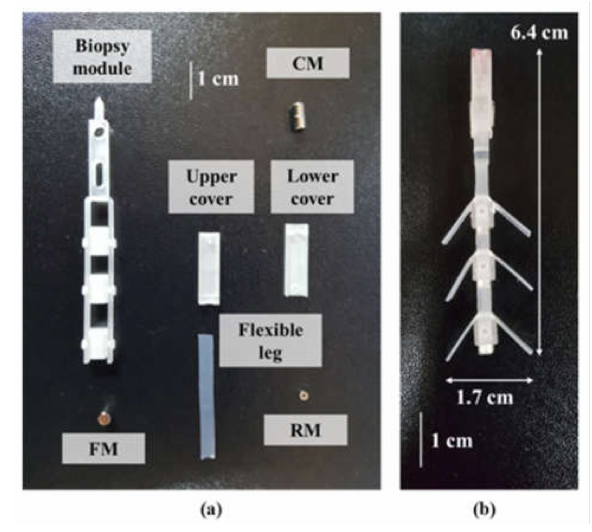
Figure 8. ( a ) Components of the CMR. ( b ) Assembled